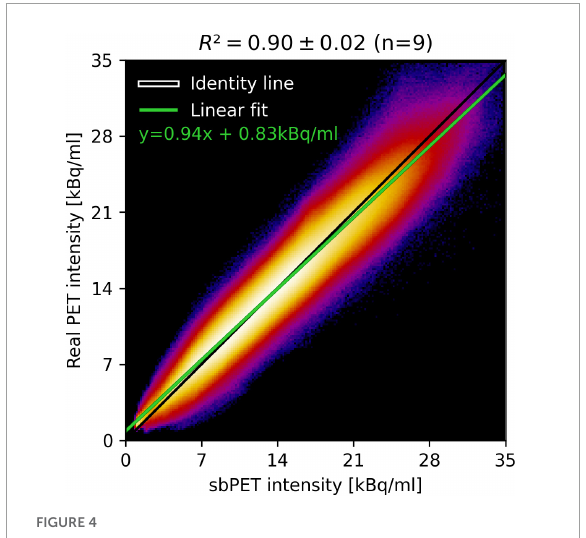
FIGURE4 Summed joint histogram of predicted and true uptake for within-brain voxels of the CN test group and the corresponding linear fit (green). The average explained variance ( R 2 ) is calculated for the linear fit with the standard deviation as uncertainty measure.